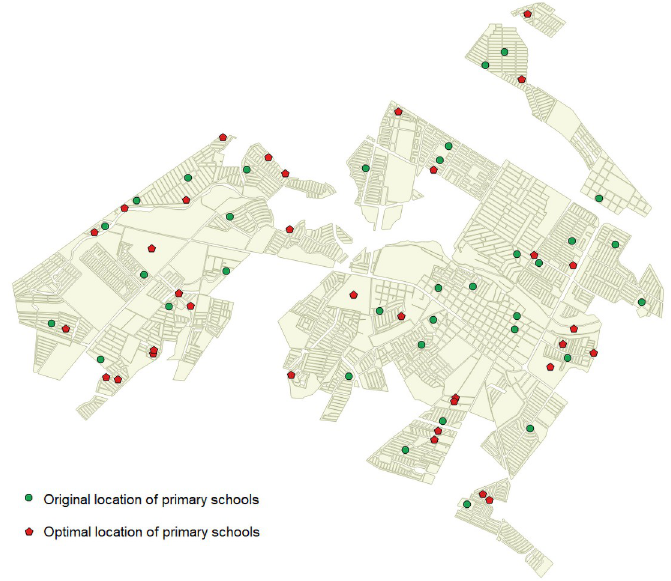
Fig 8. Comparison of original locations of schools and optimal locations of